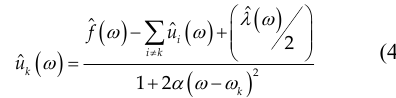
Figure 1. IMF components obtained by decomposing synthetic data with